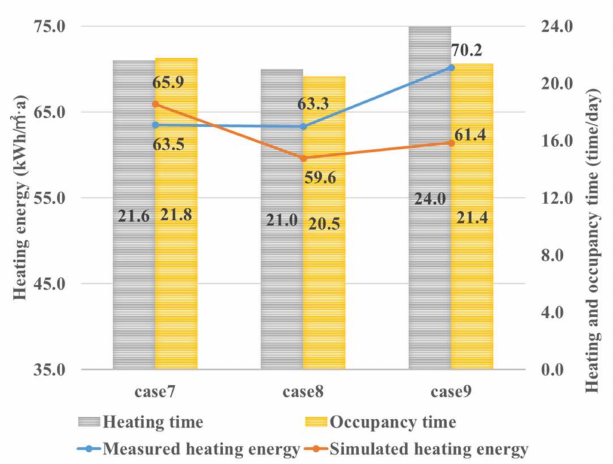
Figure 18. Comparison between the measured heating energy consumption and simulation as well as living pattern (case